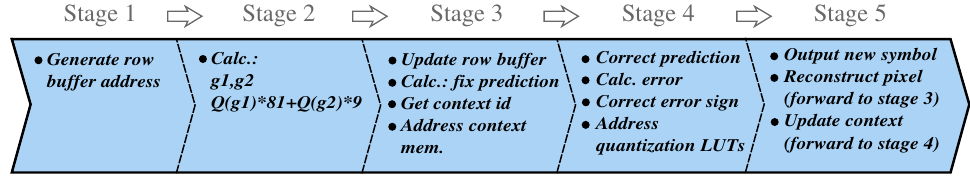
Figure 3. Pixel decorrelator